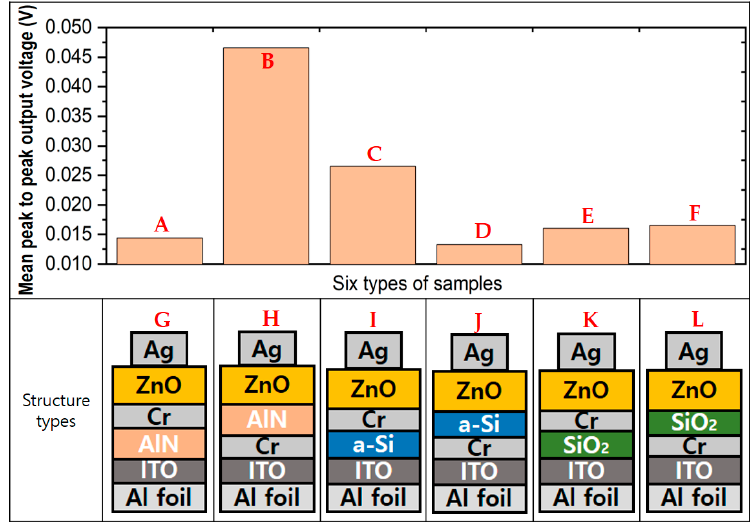
Figure 10. Design and fabrication of device samples adopting AlN, a-Si (n-type), or SiO 2 . All the fabricated devices ( G – L ) were annealed at 300 ◦ C for 1 h in the one-step annealing process defined in Figure 3. The mean peak-to-peak output voltages of the six sample structures ( A – F ) are compared in the histogram ( top ). The six sample structure diagrams ( G – L ) correspond to the mean peak-to-peak output voltage histogram directly above it ( A – F ) ( bottom ). Device structures are as follows: ( G ) Ag / ZnO / Cr / AlN / ITO / Al-foil, ( H ) Ag / ZnO / AlN / Cr / ITO / Al-foil, ( I ) Ag / ZnO / Cr / a-Si / ITO / Al-foil, ( J ) Ag / ZnO / a-Si / Cr / ITO / Al-foil, ( K ) Ag / ZnO / Cr / SiO 2 / ITO / Al-foil, and ( L ) Ag / ZnO / SiO 2 / Cr / ITO / Al-foil.